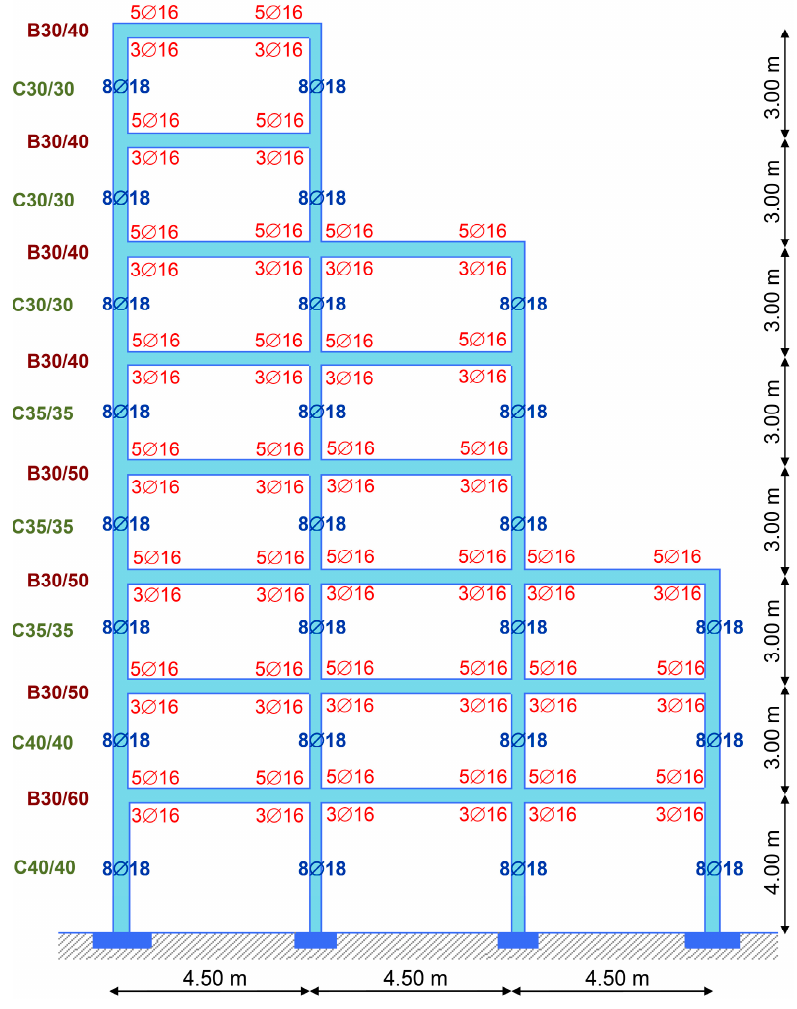
Figure 8. Frame A4 properties.